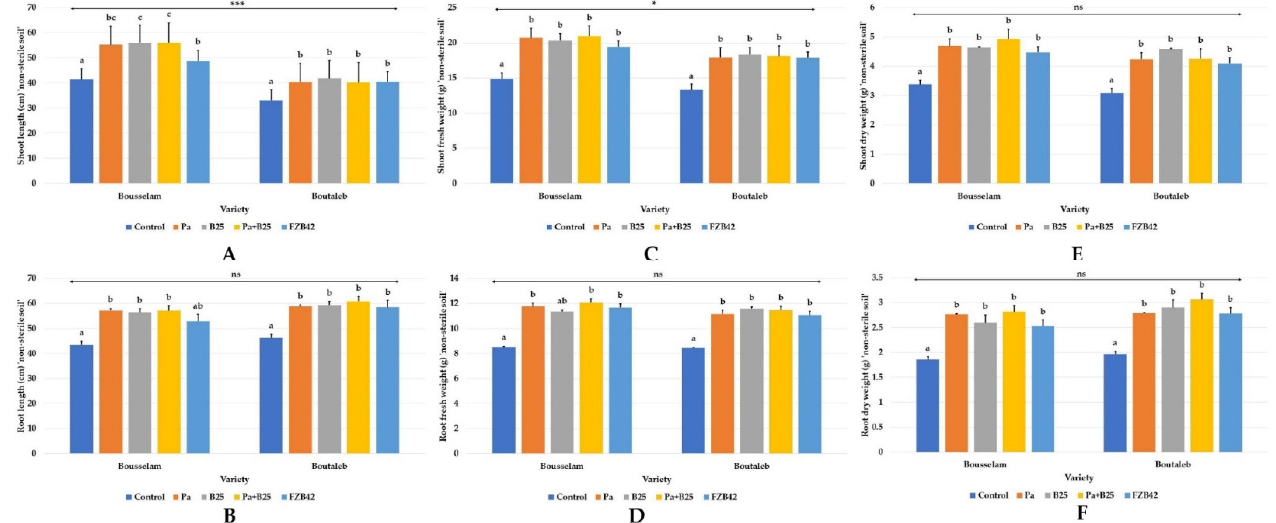
Figure 8. Effect of bacterial inoculation on ( A , B ) shoot and root length (cm), ( C , D ) shoot and root fresh weight (g), and ( E , F ) shoot and root dry weight of wheat plants grown on non-sterile soil of Bousselam and Boutaleb varieties. The bar plots represent the mean ± standard error of three different experiments. IBM SPSS Statistics v.24 was used to perform statistical analysis, using a two-way ANOVA and Tukey’s multiple comparison post-test. Significant differences are displayed as: * p < 0.05, *** p < 0.001. ns: non-significant.